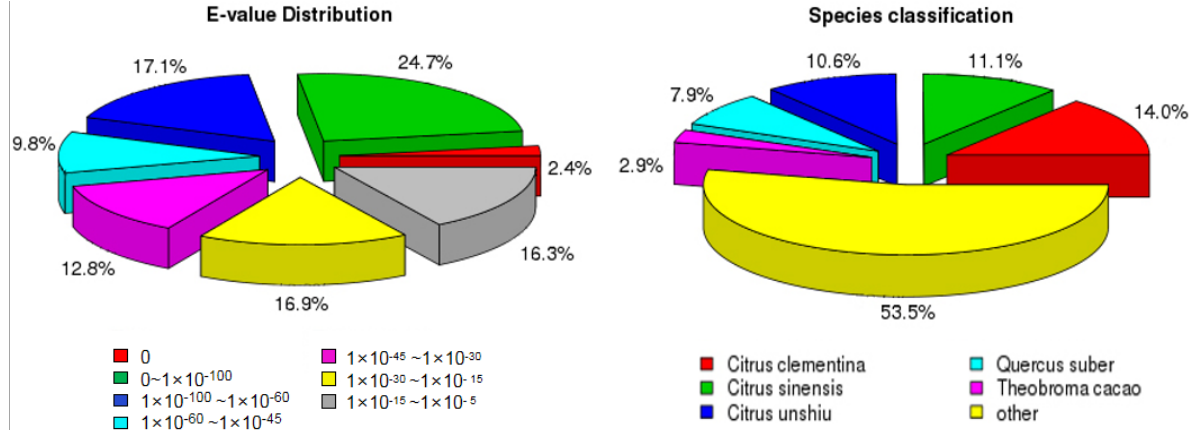
Figure 1. Distribution of unigenes: Left , E-value distribution map of Nr in the NCBI database; right , species distribution map of Nr.